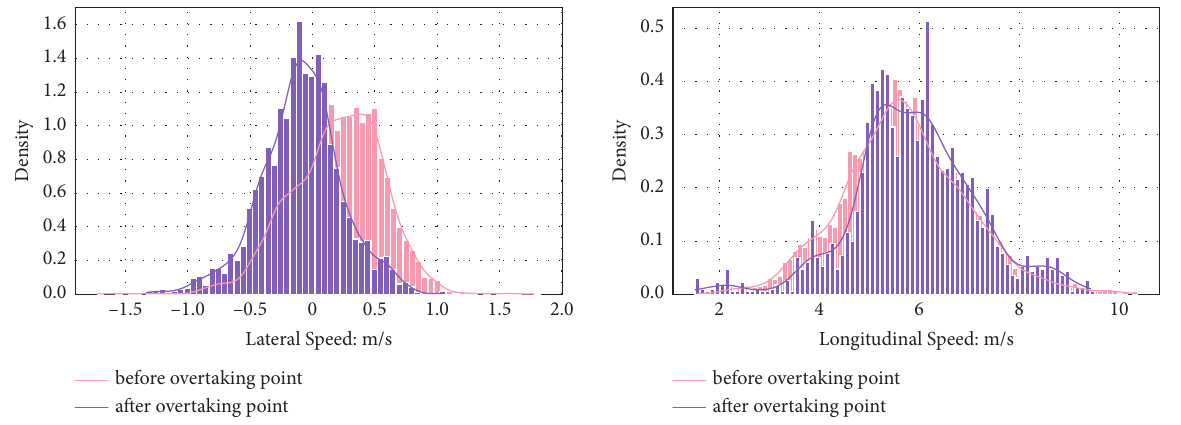
Figure 9: Speed comparison before and after